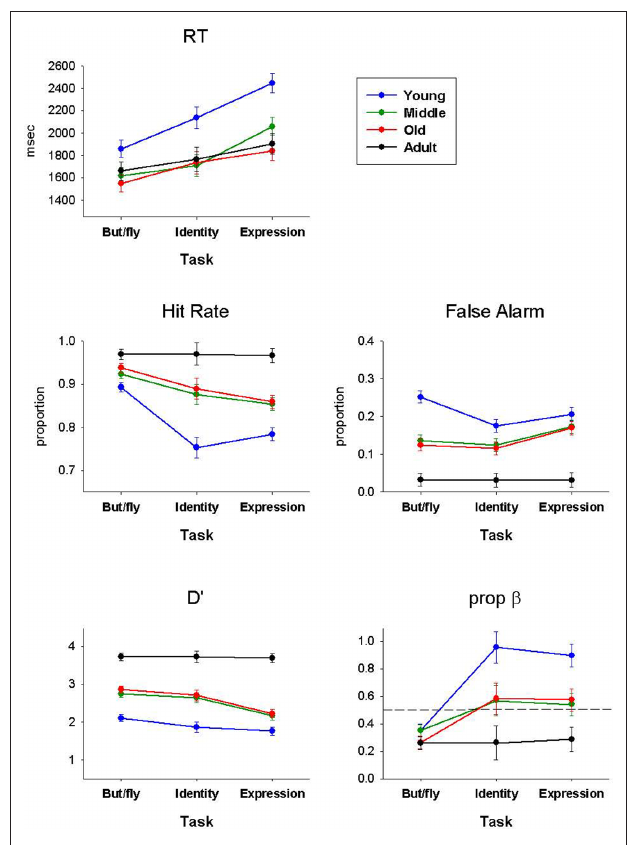
Figure 2 | Behavioral measures for each task arranged by age